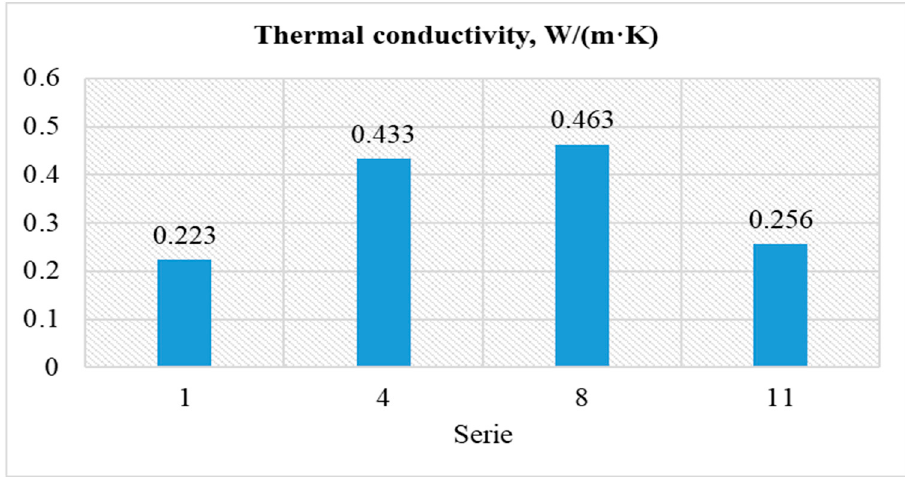
Figure 11. Values for the thermal conductivity coefficient “ λ ”.